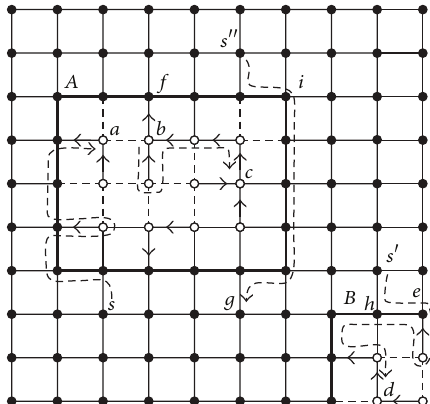
Figure 3: 𝐴 and 𝐵 are two cracky rectangular blocks. 𝐴 is a general cracky block, while 𝐵 is a cracky block which is induced by the faulty links on the boundary of the mesh, and it is an incomplete cracky block. As nodes 𝑎, 𝑏 , and 𝑑 in the cracky blocks 𝐴 and 𝐵 are faulty nodes, 𝑓 and 𝑖 are border nodes, and any node outside of 𝐴 and 𝐵 is good node. With the cracky rectangular block, not only good node 𝑠 󸀠󸀠 keeps connecting with another good node 𝑔 as general, but also the good nodes 𝑠,𝑠 󸀠 can send messages to faulty nodes 𝑎, 𝑑 , respectively;whatismore,thosefaultynodescancommunicatewith each other, such as nodes 𝑏 and 𝑐